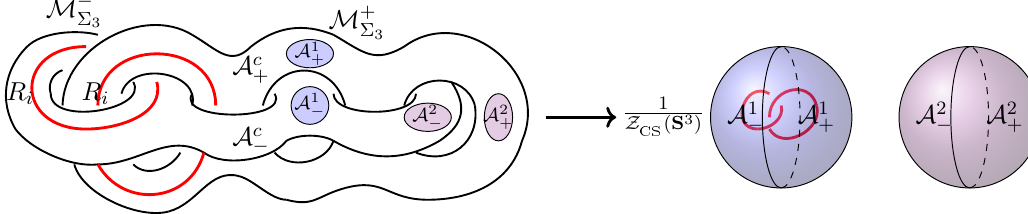
Figure 17 . The state j (cid:9) i i on a genus three Riemann surface (cid:6) 3 can be constructed by performing 3 the path integral over the handle body M (cid:0) , a 3-manifold obtained by (cid:12)lling all the three indepen- (cid:6) 3 dent a -cycles of (cid:6) 3 , with a Wilson loop along one of its non-contractible b -cycle in representation R i . The dual state h (cid:9) i j can be constructed by performing the path integral over another handle 3 body M + obtained by (cid:12)lling the b -cycles of (cid:6) 3 , with a Wilson loop along its non-contractible (cid:6) 3 a -cycle in representation R i . The path integral representation of (cid:26) of j (cid:9) i i for the bipartition of A (cid:6) 3 into two regions A = A 1 [ A 2 and A c can be obtained by gluing the path integrals over M + (cid:6) 3 and M (cid:0) by identifying the regions A c and A c on their boundaries. The resultant path integral (cid:0) + (cid:6) 3 can be understood as a path integral over two 3-balls, one without any Wilson lines and the other with a Wilson line placed along a knot in it, normalized by Z ( S 3 ). The boundary of one of them CS is given by the union of the complementary regions A 1 and A 1 , and the boundary of the other is (cid:0) + given by the union of the complementary regions A 2 and A 2 (cid:0) +